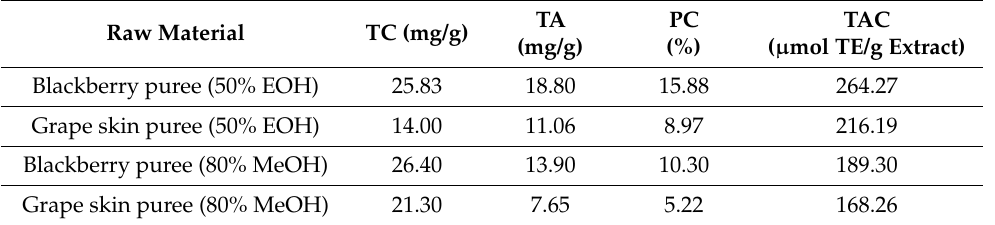
Table 1. Composition and characterization of grape skin and blackberry extracts. Raw